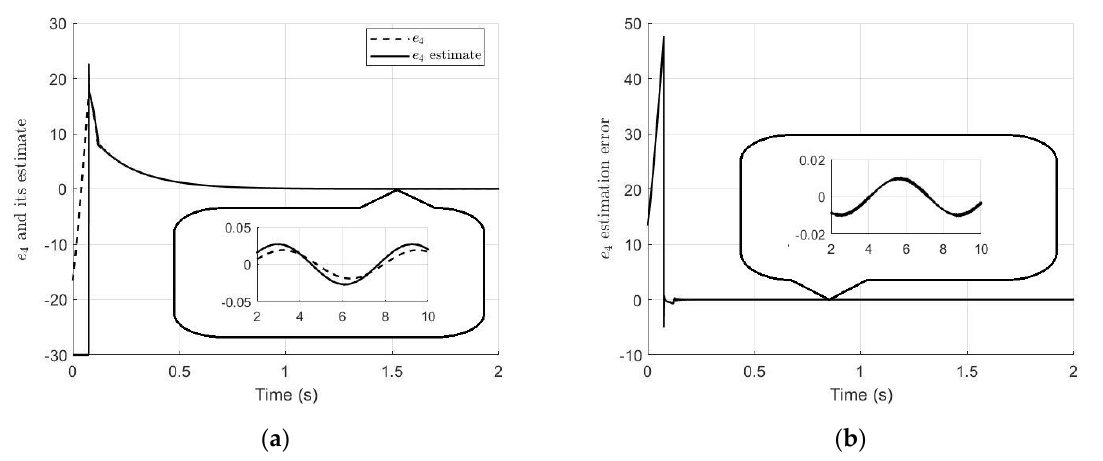
() x t ; in ( b ), plot 1